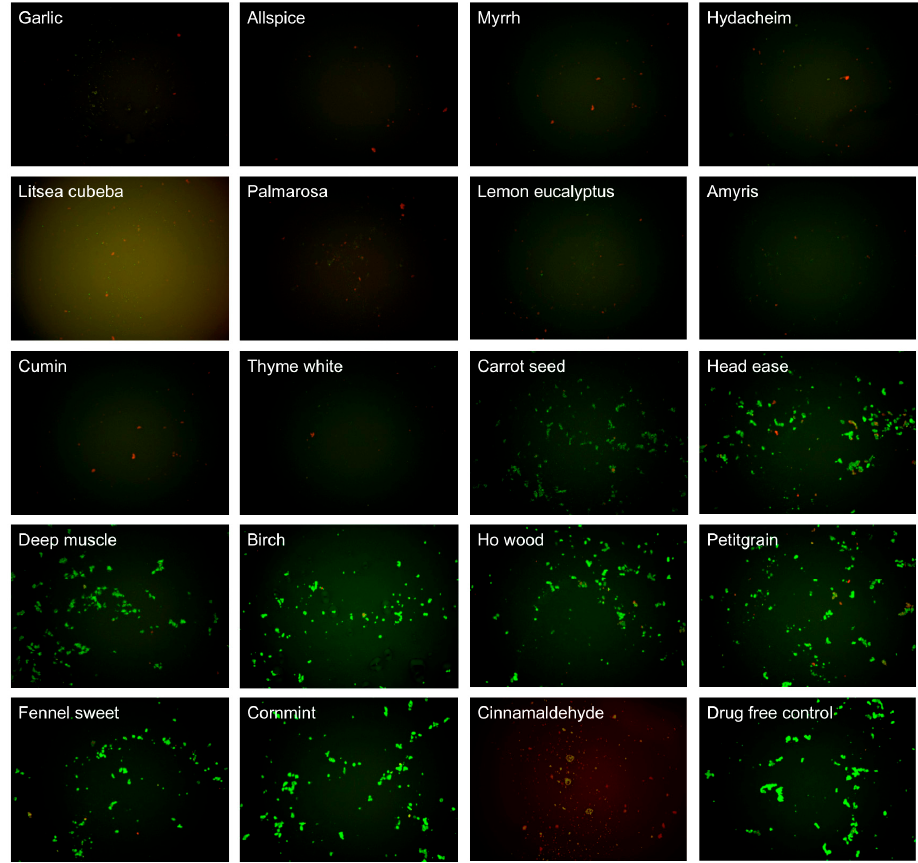
Figure 2. Effect of 0.1% essential oils on the viability of stationary phase B. burgdorferi. A seven-day old B. burgdorferi stationary phase culture was treated with 0.1% ( v/v ) essential oils for seven days followed